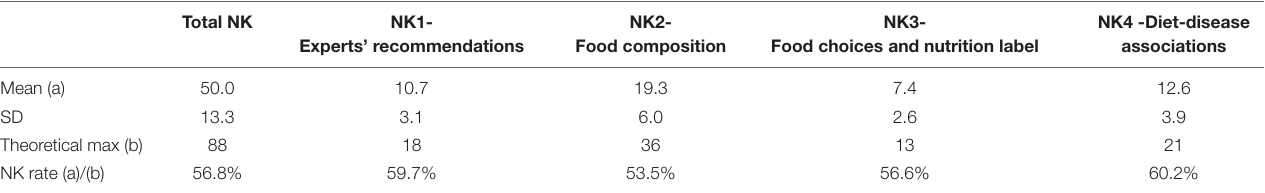
TABLE 2 | Nutrition knowledge assessment in